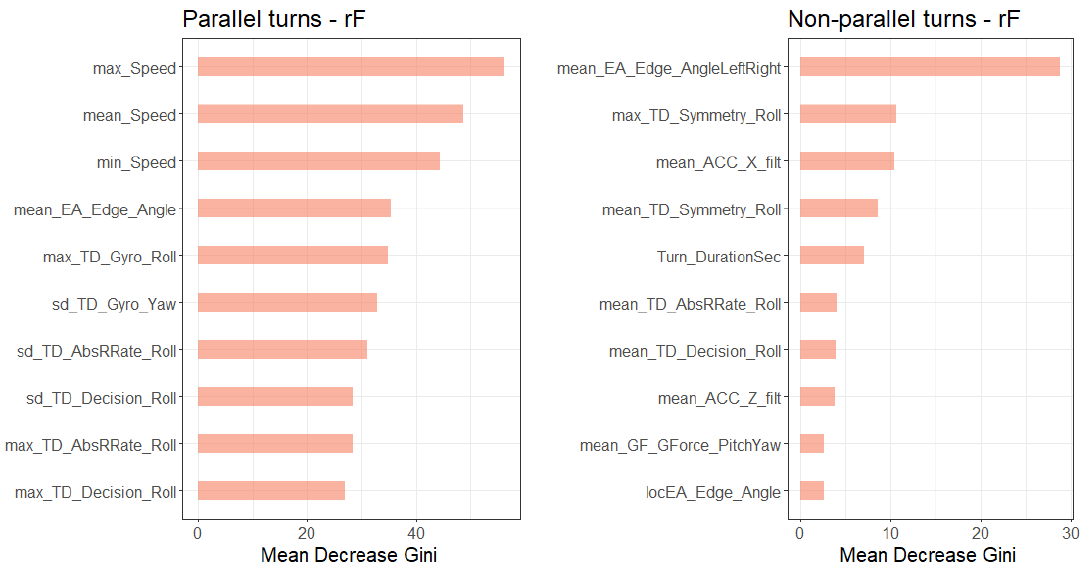
Figure 9. Variable importance plot of the 10 most important variables of the random forest.